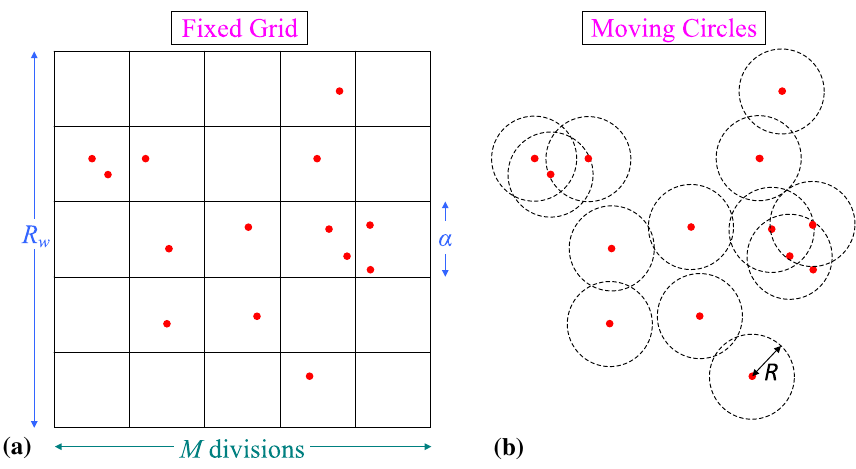
Fig. 1 The calculation procedure of factorial moments of second order, F 2 , in a and correlation integral, C , in